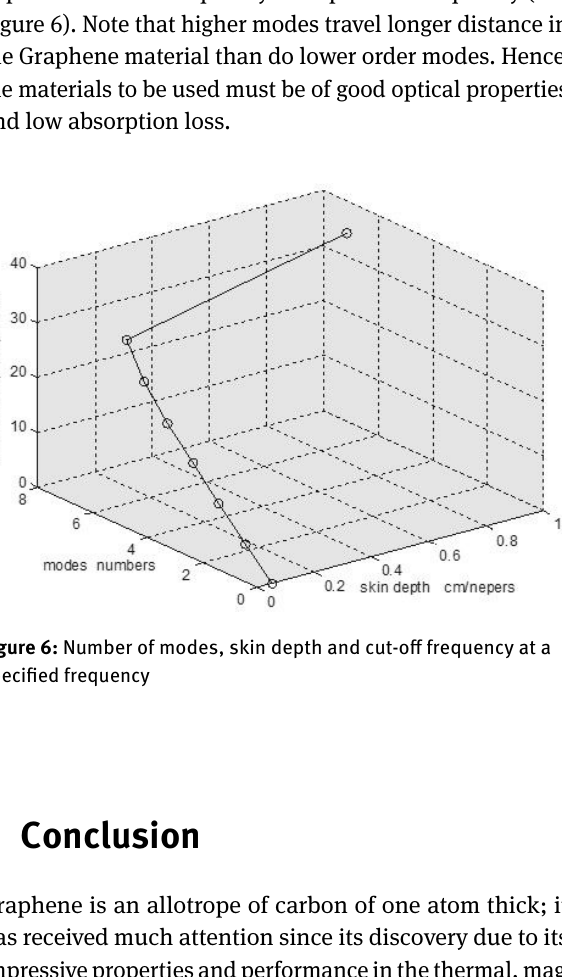
depth and cut-off frequency at a specified frequency (see Figure 6). Note that higher modes travel longer distance in the Graphene material than do lower order modes. Hence, the materials to be used must be of good optical properties and low absorption loss.